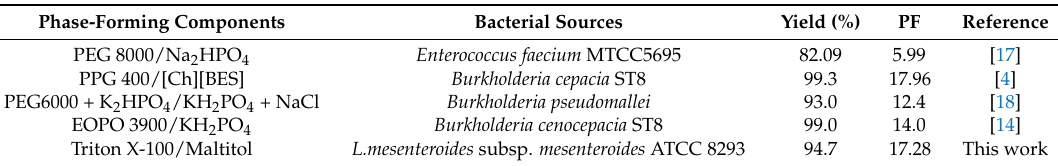
Table 3. A comparison of lipase purification results of previously reported ATPS with the purification results of the present